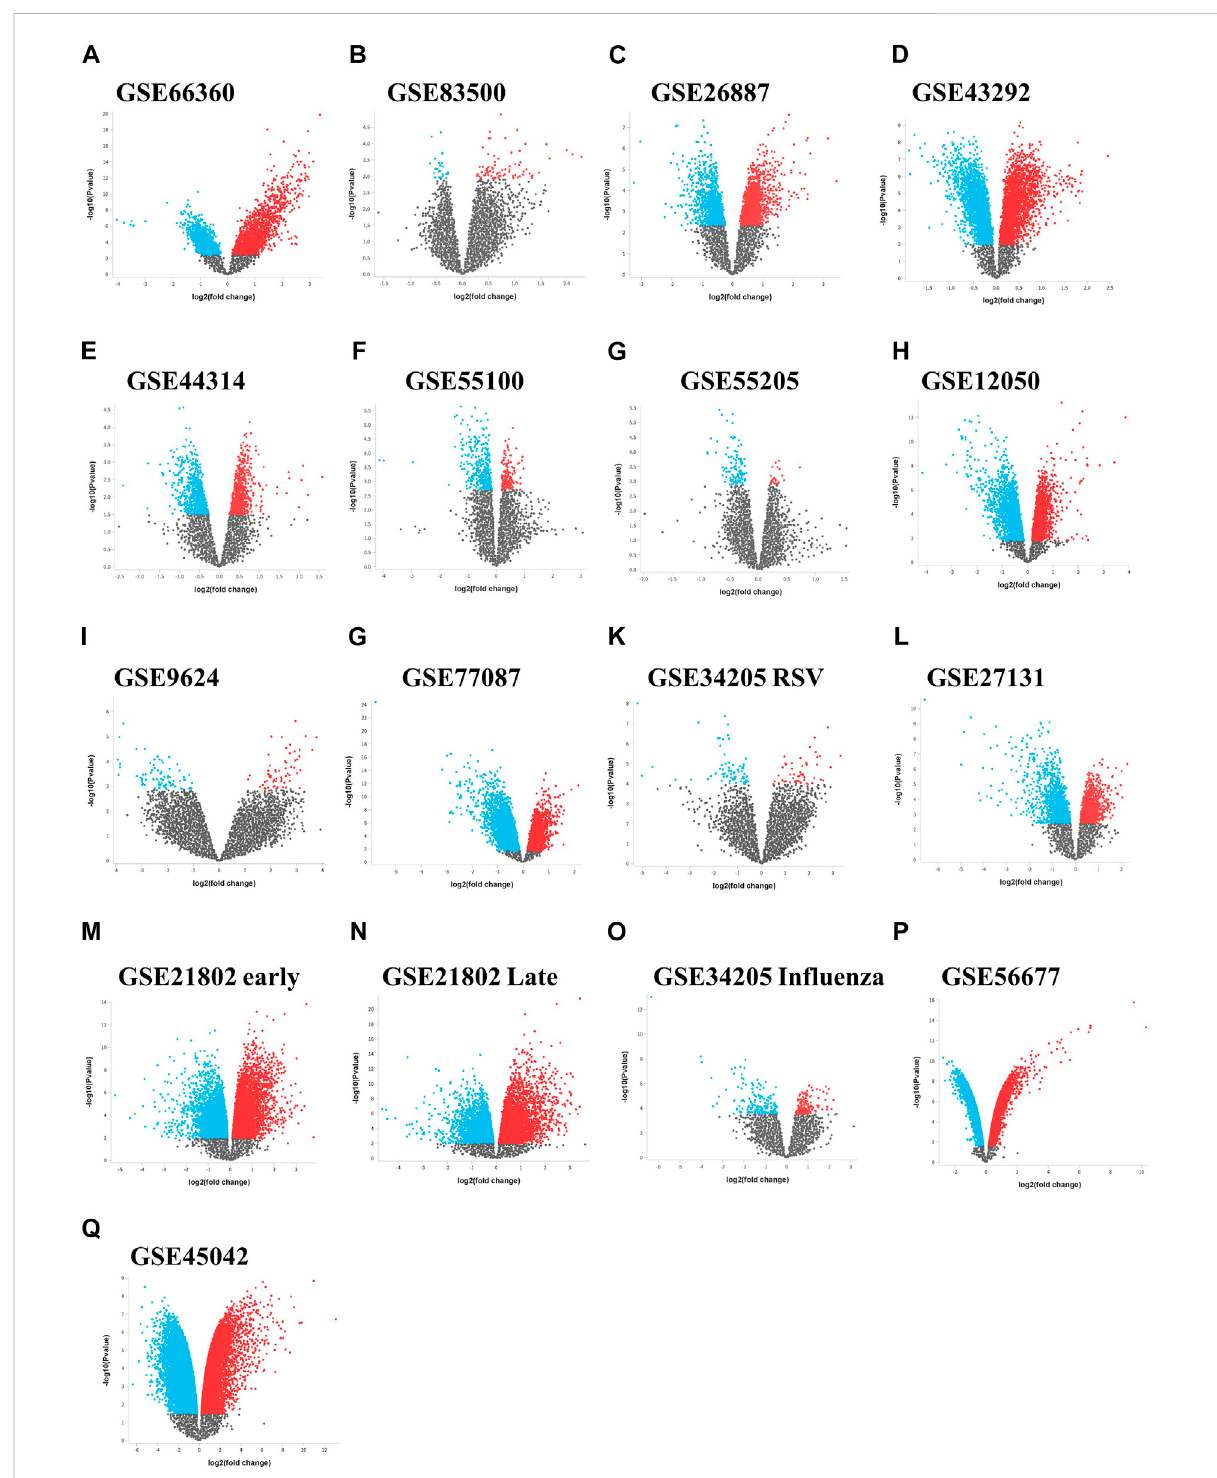
FIGURE 2 Differential expression volcano plots across data sets. Volcano plots of the gene expression data from (A – I) the comorbidities category, (G – M) lung infection category including in fl uenza and (P,Q) MERS infection category. The horizontal axis represents the log2 (fold change) and the vertical axis represents the-log10 ( p -value). The colored dots represent the signi fi cant DEGs with adjusted p -values < 0.05. DEGs, differentially expressed